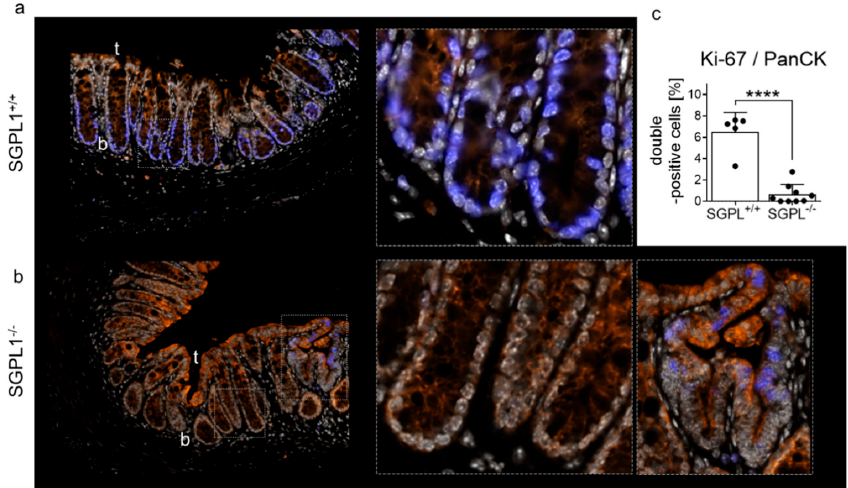
Figure 2. Staining of ( a ) wildtype (SGPL +/+ ) and ( b ) SGPL1 knockout (SGPL − / − ) colon sections after CAC induction (9 weeks): Dapi (white), Anti-PanCytokeratin (orange), Anti-Ki-67 (blue); (magnification 40 × and enhanced crypt bottoms according to frame). ( c ) Quantification of Ki-67/PanCK double positive cells within colon sections without tumors (each black dot represents a single colon section); CAC = colitis associated colon cancer; in image: t = Crypt tip; b = crypt bottom. Significance: **** p ≤ 0.0001.